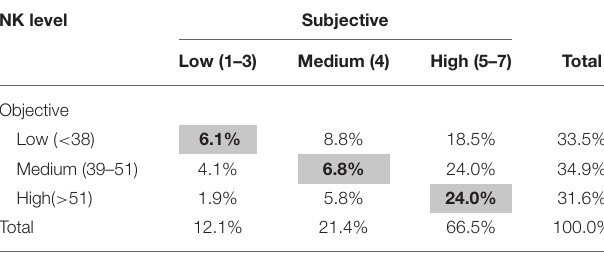
TABLE 4 | Objective vs. subjective nutrition knowledge: the gap